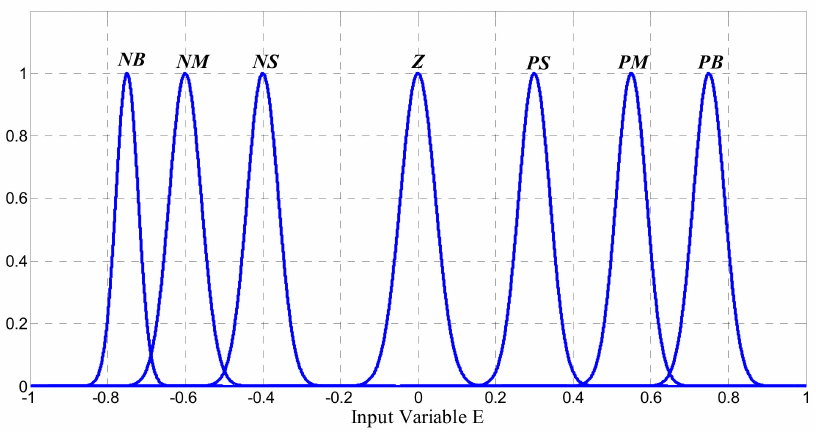
Figure 10. Gaussian membership function for E ( t )